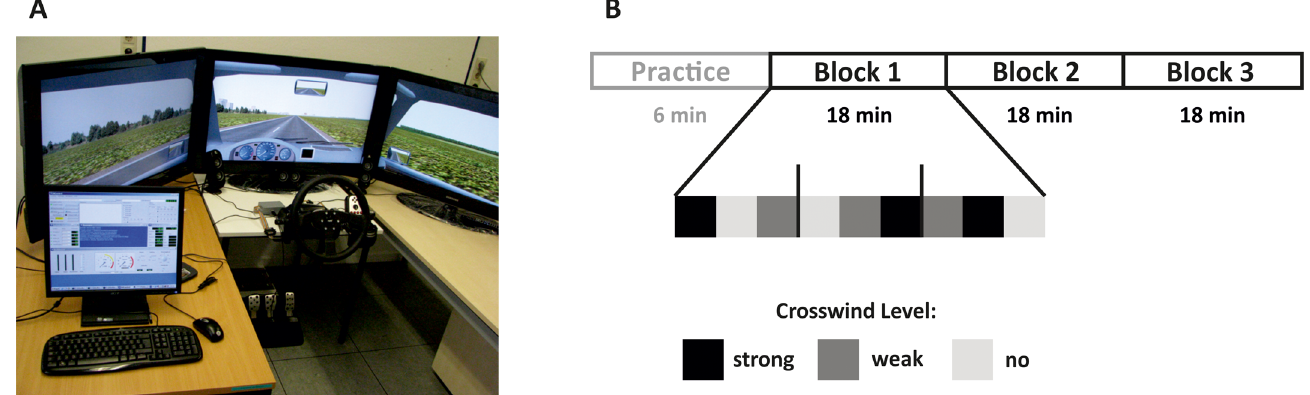
Fig 1. Experimental design. (A) Experimental environment with driving simulator configuration and (B) task set-up with one initial practice block followed by three experimental blocks. Each experimental block consisted of nine segments with three different crosswind levels.